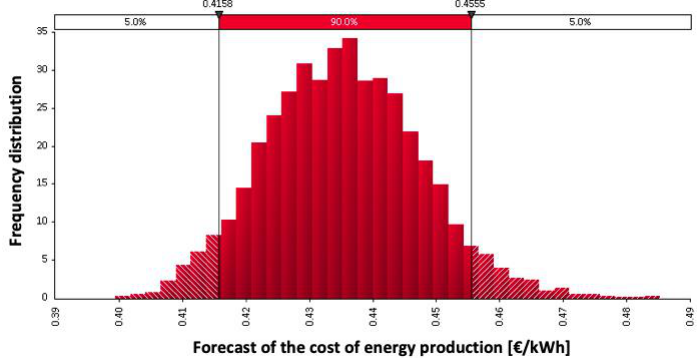
Figure 9. Calculation of the unit cost of energy production based on the forecasted energy values.